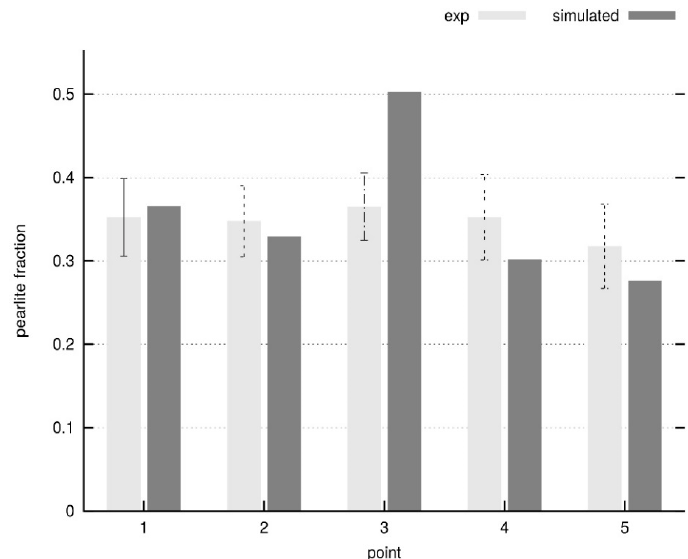
Figure 11. Experimental and simulated pearlite fraction per unit area at each of the five regions. Standard deviations for the experimental measurements are indicated.